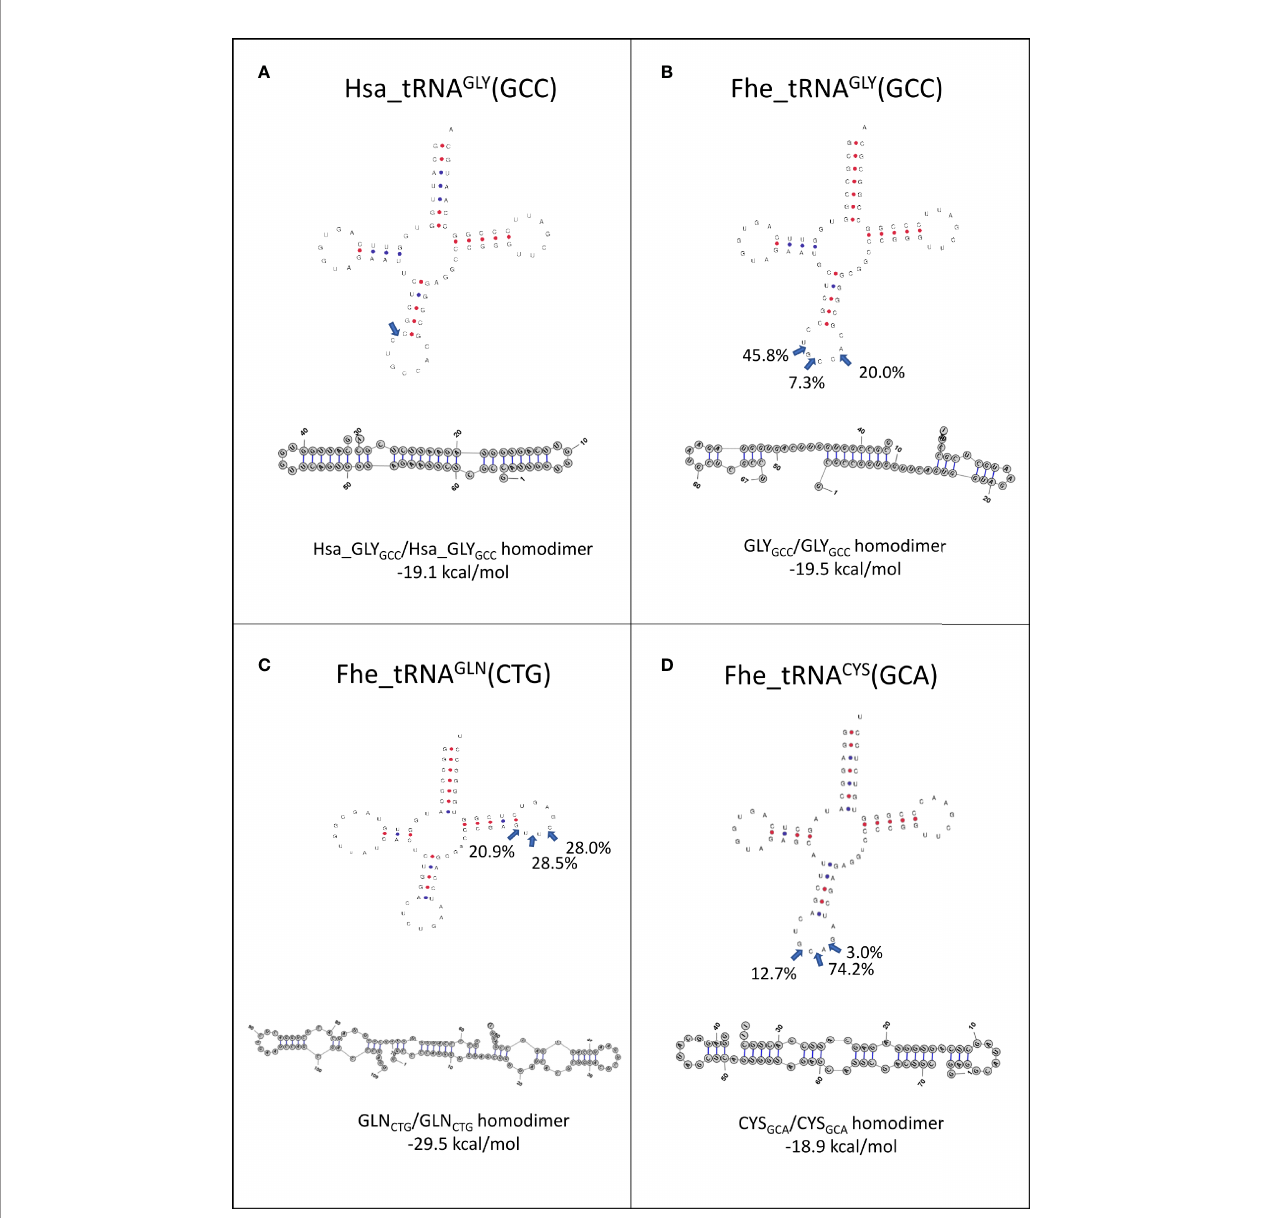
FIGURE 7 | Folding of tRNAs-derived fragments. Full length tRNA secondary structures were predicted with tRNAscan-SE (http://lowelab.ucsc.edu/tRNAscan-SE/), position and frequency of the most frequent cleavage sites in EVs are indicated (blue arrows). Homodimer structures and energy in kcal/mol for: (A) Hsa_Gly GCC , (B) Fhe_Gly GCC , (C) Fhe_Gln CTG and (D) Fhe_Cys GCA as predicted by RNAstructure6.3 for the most abundant